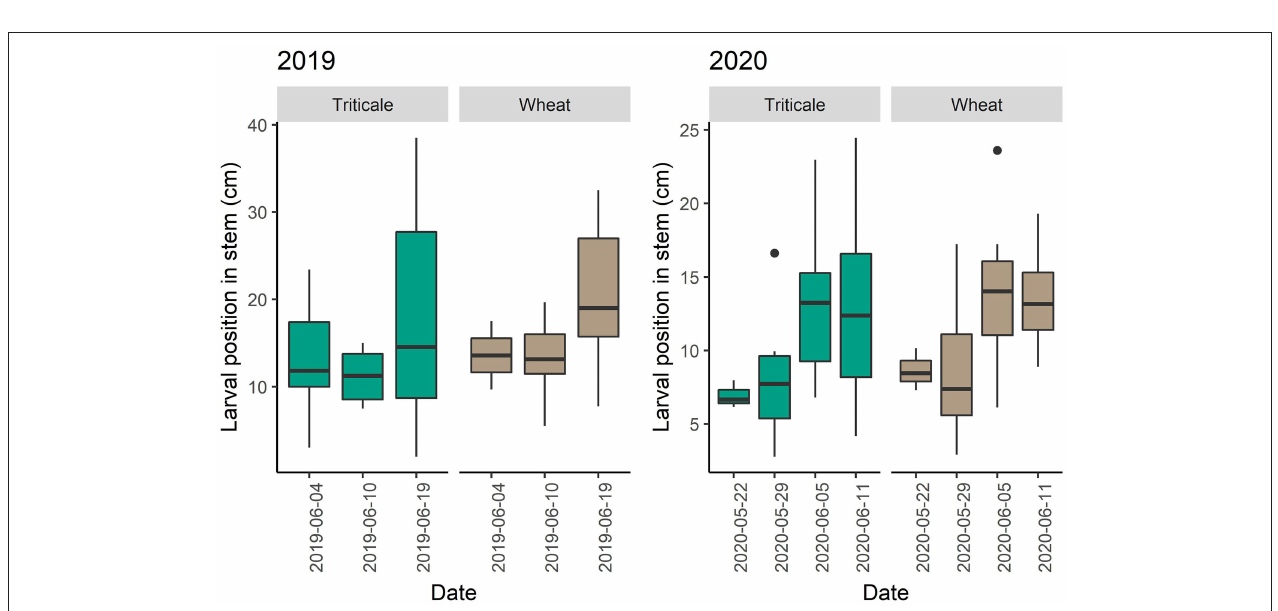
FIGURE 5 | Changes in wheat stem sawfly larval position from the roots across dates and type of crop (wheat or triticale). Boxplots showing average larval position in the stem during collection dates in 2019 and 2020.